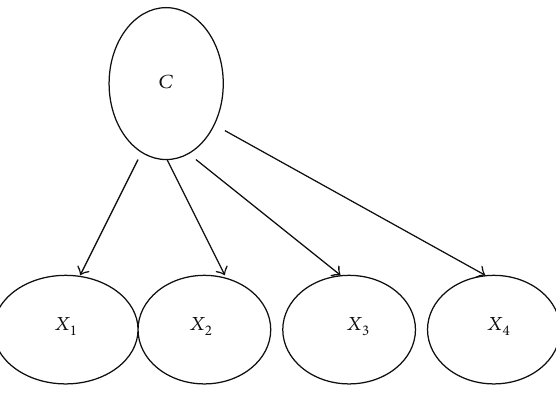
Figure 3: A simple Na¨ıve-Bayes